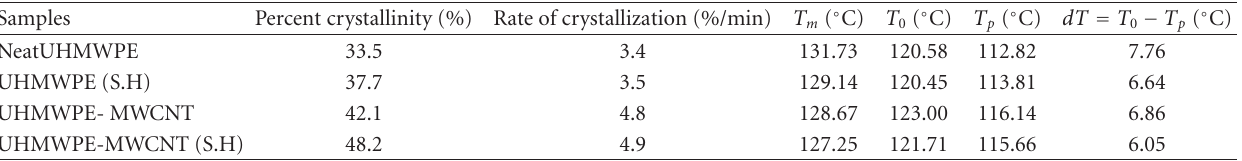
Table 3: DSC test